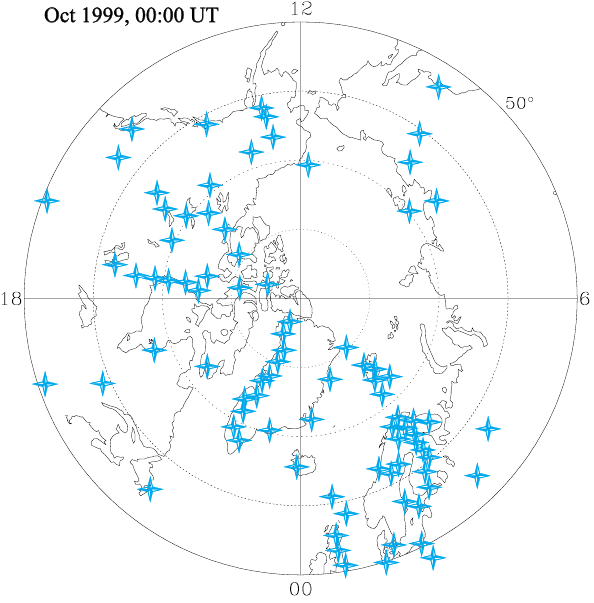
Fig. 2. A map showing the distribution of ground magnetometer stations in the northern polar region from which data is typically available at this time (the map is specifically of stations providing data in October 1999). The map is in Apex (Richmond, 1995) mag- netic latitude and magnetic local time (MLT) coordinates. Noon MLT is at the top and the distribution is shown at 24:00